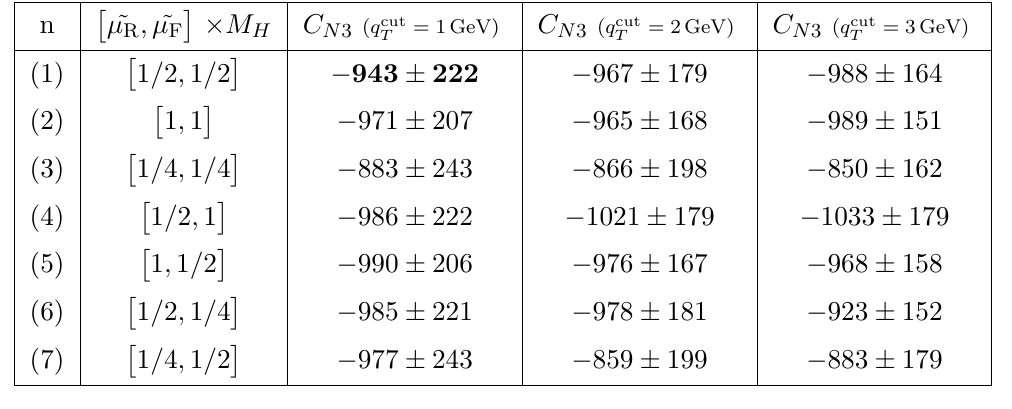
Table 1 . Extracted values of the C N 3 coe(cid:14)cients as a function of the q cut each scale choice. In bold typeface the C N 3 coe(cid:14)cient (for the case q cut